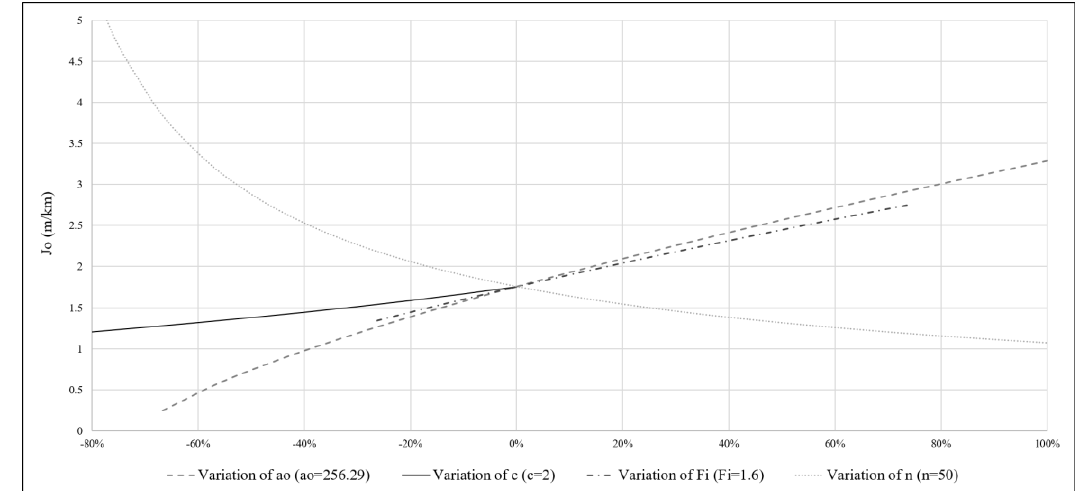
Figure 8. J 0 sensitivity to pipe’s cost ( capital expenditures, or CAPEX) parameters (case 1, steady network).